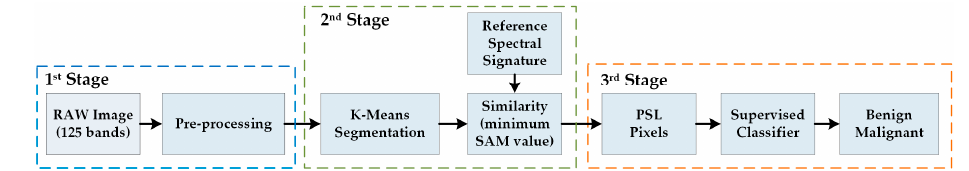
Figure 10. Block diagram of the HS dermatologic framework for in-situ clinical support